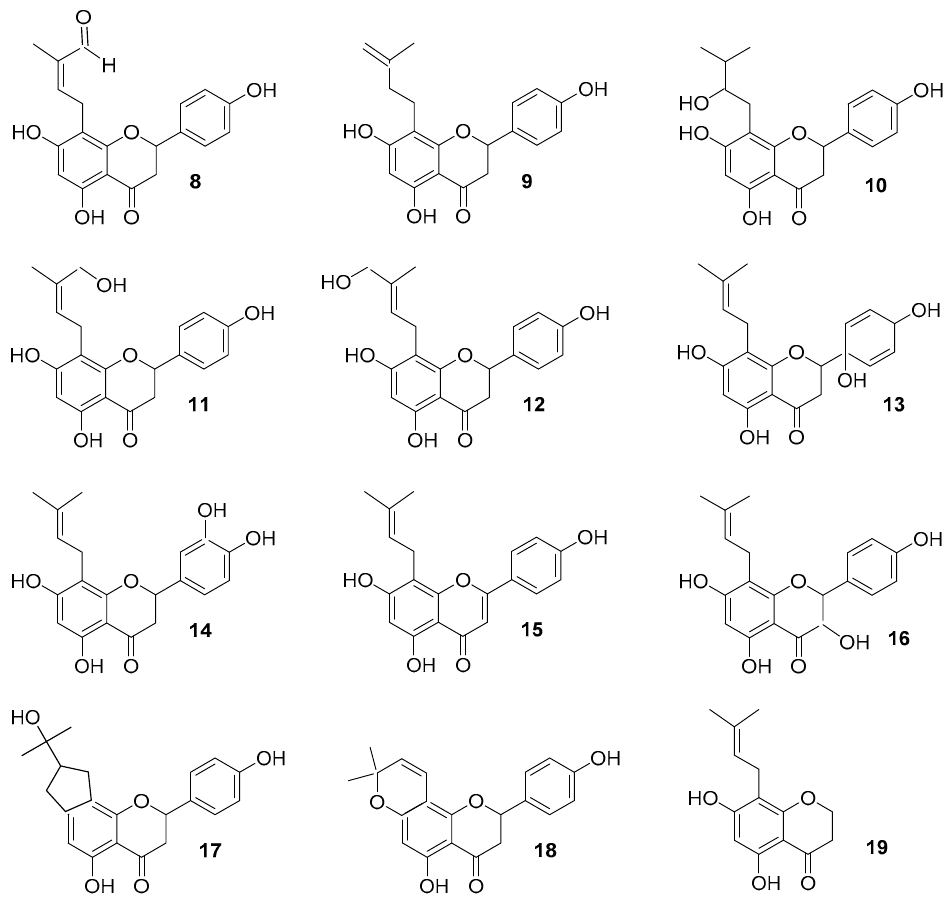
Figure 4. Human liver microsomes metabolites ( 8 – 19 ) of 8-PN ( 4 ) [40].